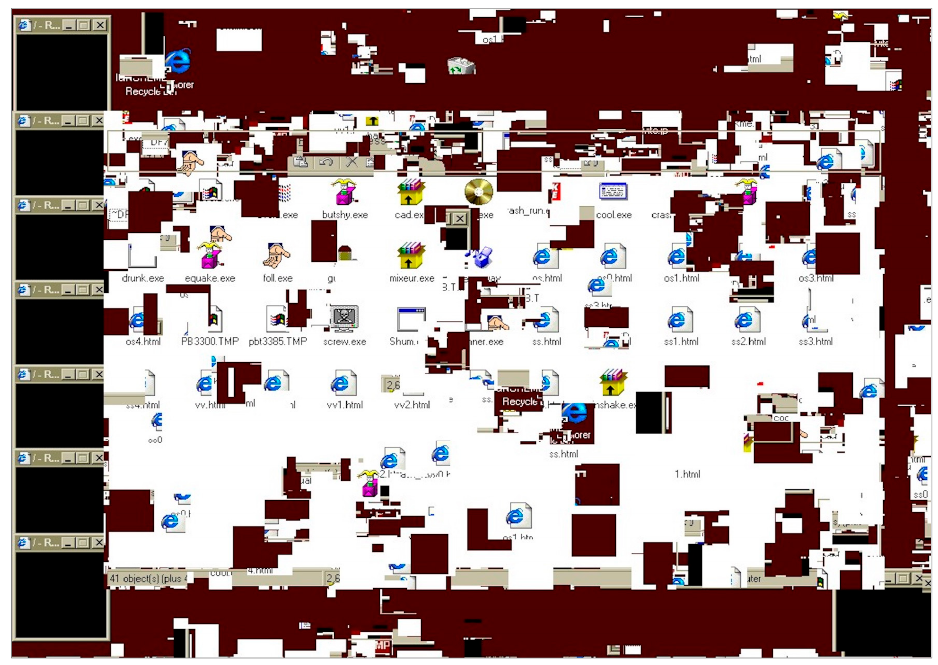
Figure 4. Kiran Subbaiah, CrashRun.exe , 2002. Screenshot of the artwork, 2016. © Kiran Subbaiah, 2019.